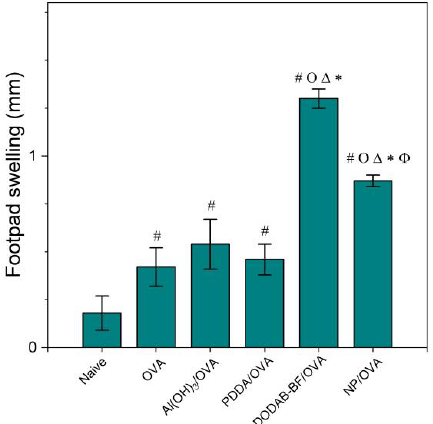
Figure 8. Mean footpad swelling ± standard deviation related to the delayed-type hypersensitivity reaction of BALB/c mice immunized with OVA, Al(OH) 3 /OVA, PDDA/OVA [20], DODAB-BF/OVA [44], or PMMA/DODAB/PDDA NPs carrying OVA (NP/OVA). p < 0.05 compared to the naive group (#), p < 0.05 compared to the OVA group (o), p < 0.05 compared to the Al(OH) 3 /OVA group (∆), p < 0.05 compared to the PDDA/OVA group (*), or p < 0.05 compared to the DODAB-BF/OVA group (ϕ). The controls for PDDA/OVA and DODAB BF/OVA previously published (naïve, OVA) were very similar to those shown here for NP/OVA.